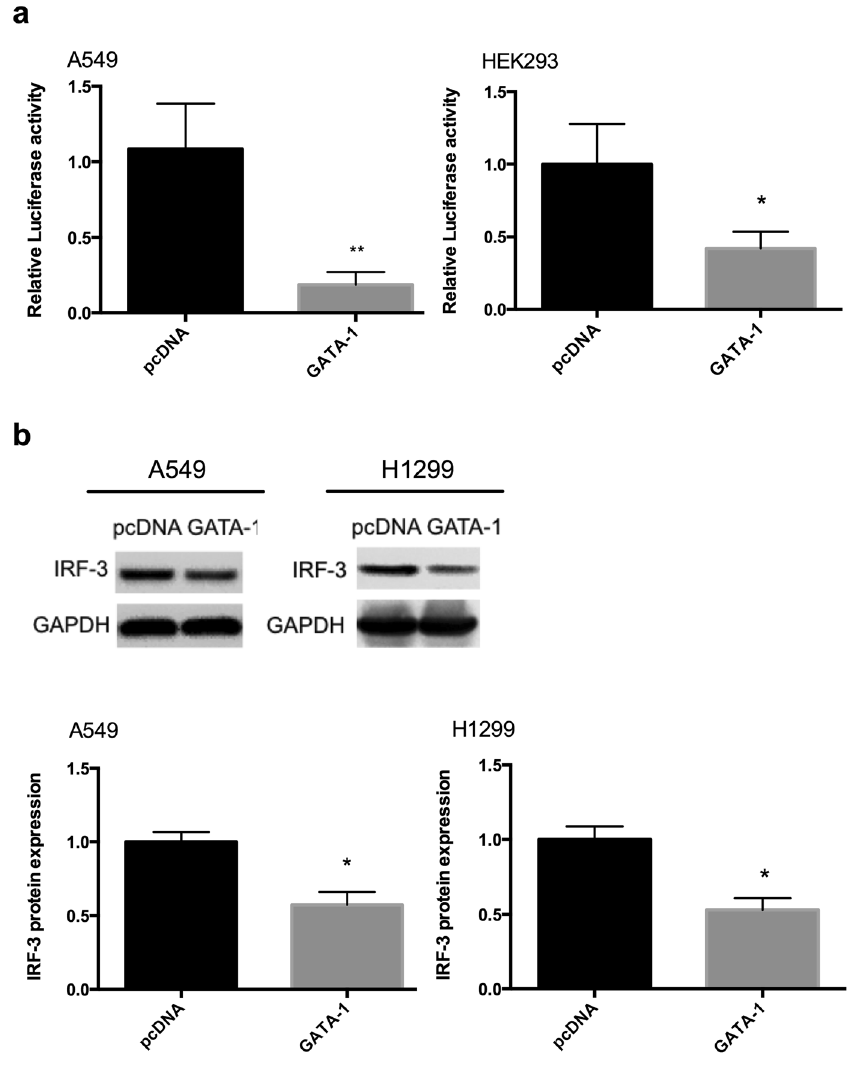
by overexpressed GATA-1 in different lung adenocarcinoma cell lines. GAPDH was used as a loading control. Error bars represent the mean ± S.D. from three independent experiments ( * p < 0.05; ** p < 0.01). The full- length blots were presented in Supplementary Figure